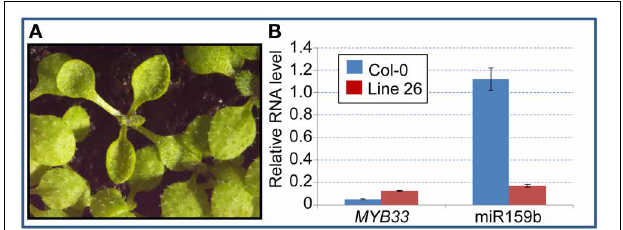
FIGURE 1 | Phenotype and molecular characteristics of the Line 26 hyponastic mutant. (A) A Line 26 M2 hyponastic mutant shown adjacent to wild type M2 siblings. (B) qRT-PCR analysis of MYB33 and mature miR159b expression in the Line 26 hyponastic mutant. Analysis was performed on RNA extracted from 3-week-old plants and mRNA abundance was normalized to cyclophilin, and miRNA analysis was normalised to sno101 , measurements being the average of three replicates with error bars representing the standard error of the